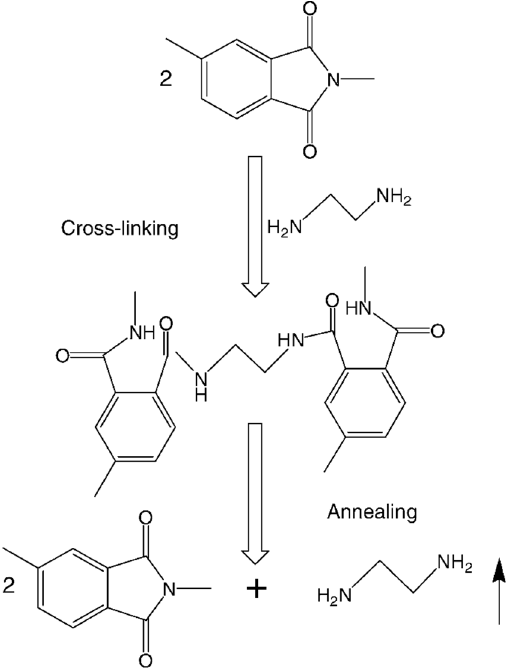
Figure 11. Possible reaction mechanisms during 1,2-ethylene diamine (EDA)-induced cross-linking and thermal annealing [64].